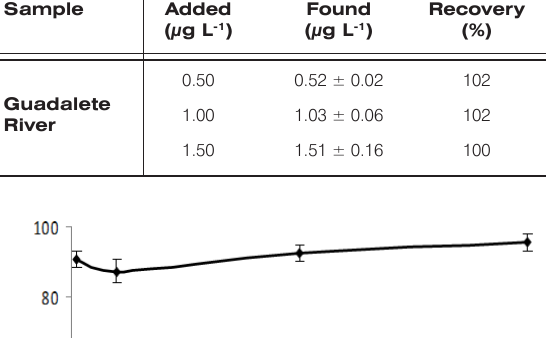
Table 2. A nalysis of cadmium in spiked water sample.